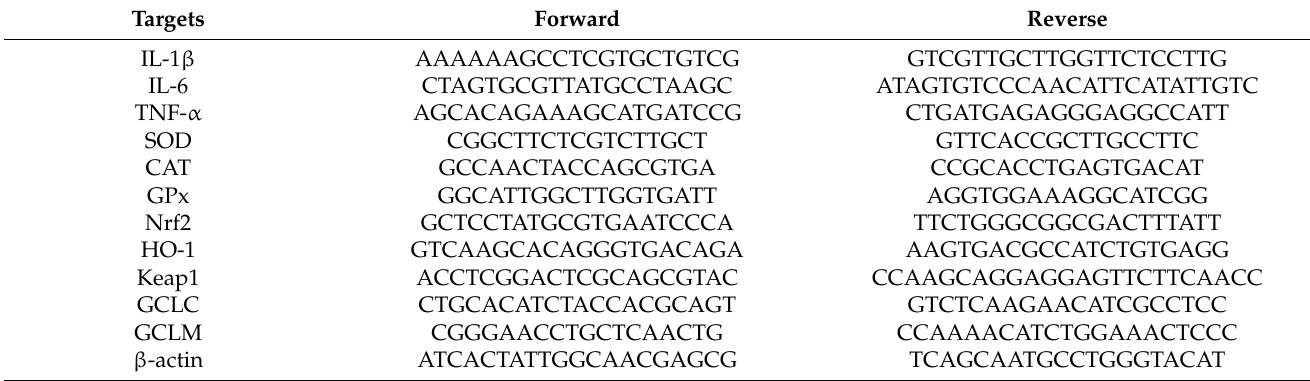
Table 1. Primer Sets for Reverse Transcriptase-Polymerase Chain Reaction